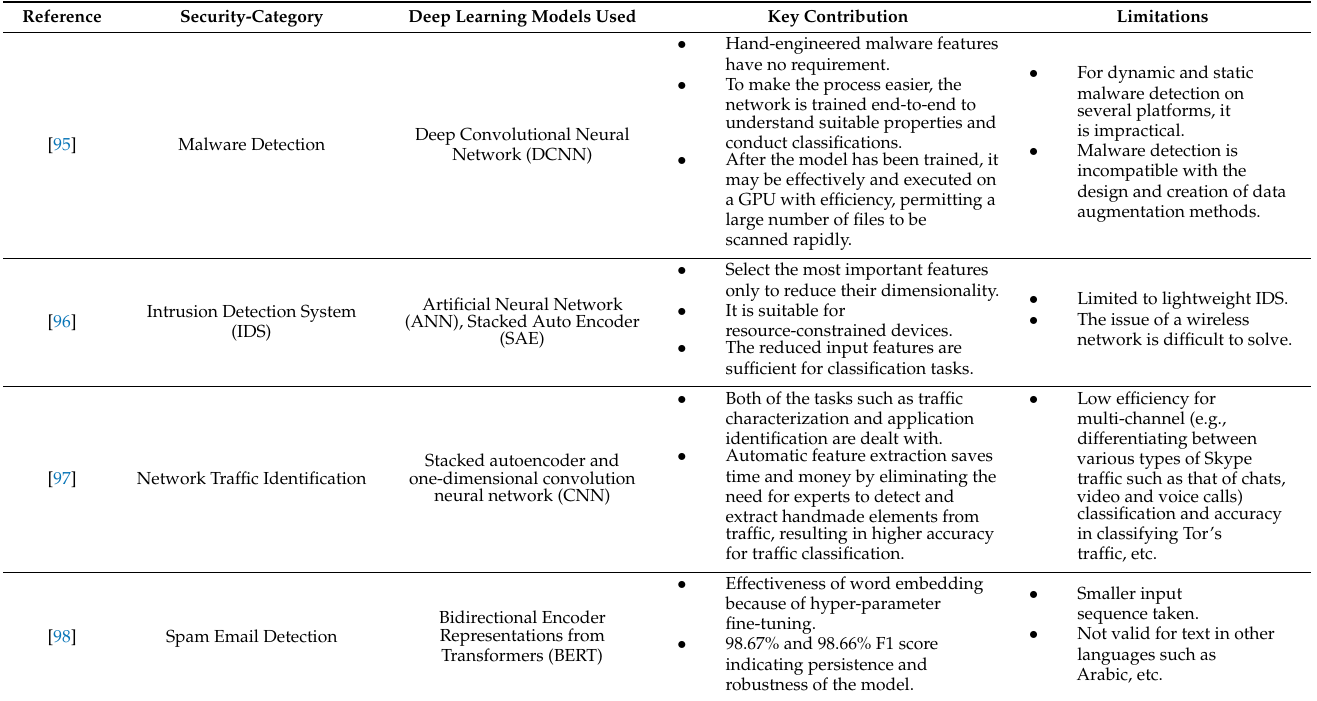
Figure 7. Taxonomy of AI-enabled electronic information security models for mobile networks. Table 3. A summary of works on deep learning models for electronic information